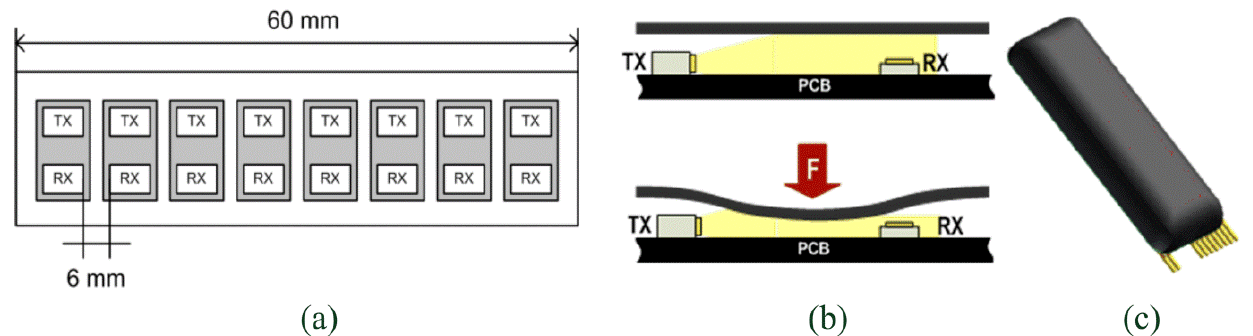
Figure 1. Overview of the PSP1: ( a ) specific scheme of the 1 × 8 array of sensitive elements of the PSP 1.0 and PSP1.1; ( b ) scheme of the transduction principle; ( c ) 3D design of the PSP1.1 (adapted from